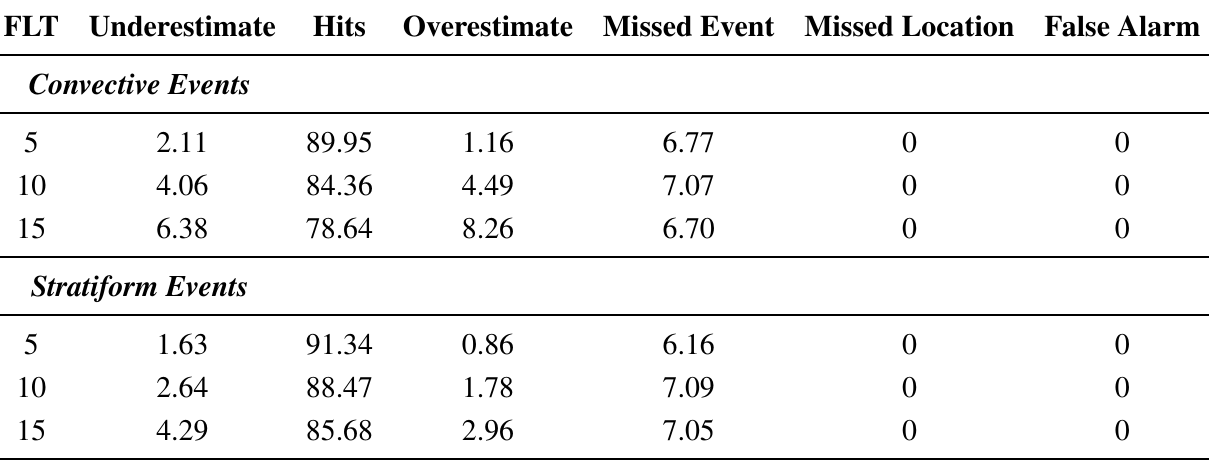
Table 6. Forecast evaluation. FLT, forecast leading time. All measures are shown as a percentage. FLT